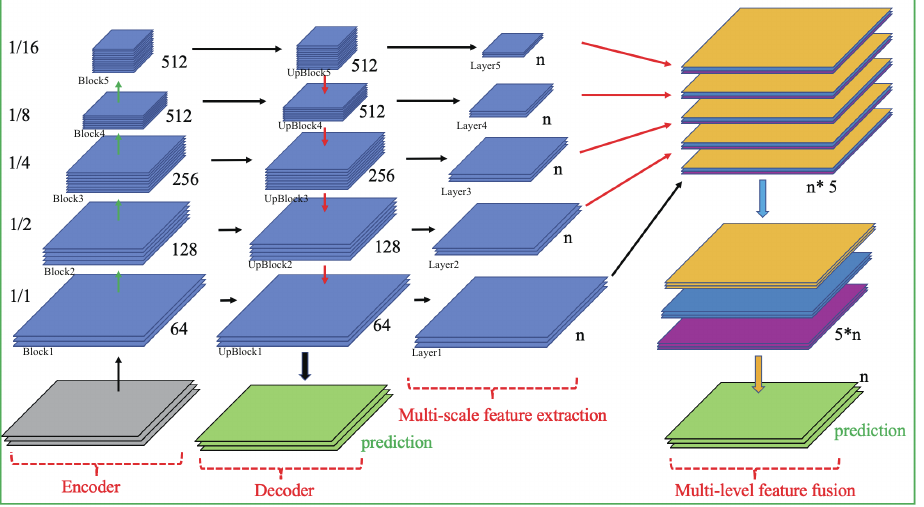
Figure 3. The ovaerall architecture of MSLF-Net. (Green arrow denotes down-sampling, red arrow denotes up-sampling, black arrow denotes information flow, blue arrow denotes channel rearrange, orange arrow denotes channel fusion, n = number of lesion types +